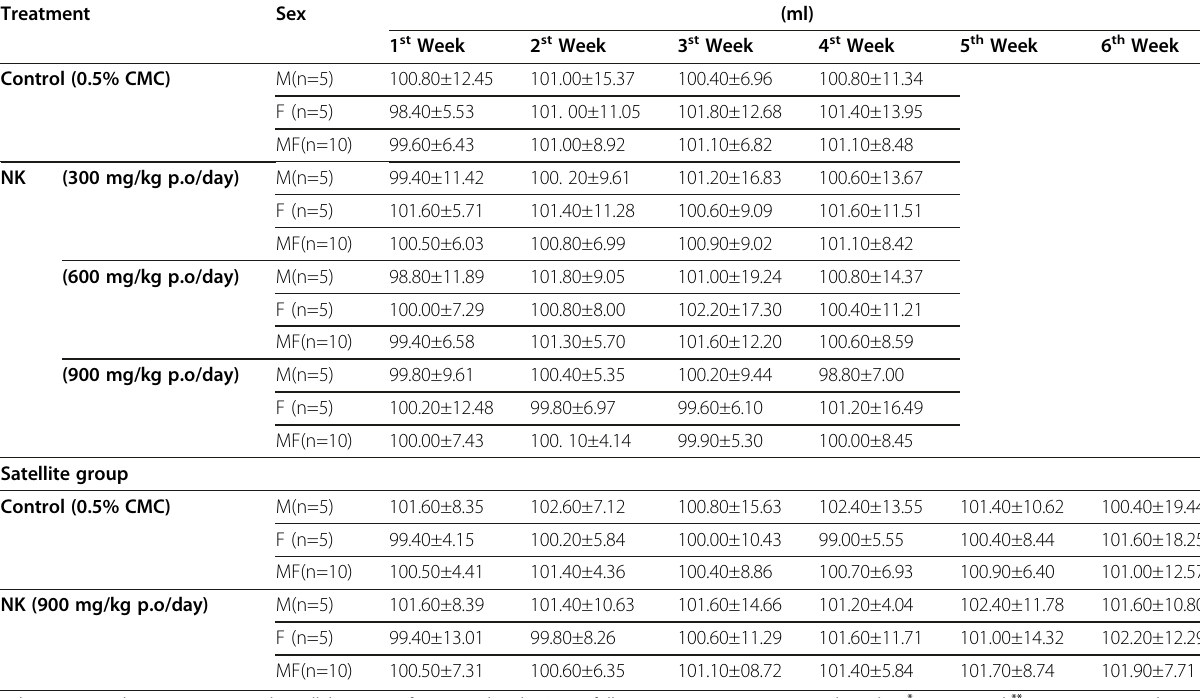
Table 6 Effect of Nuna kadugu on water consumption in experimental rats - repeated oral toxicity study Treatment Sex Control (0.5%